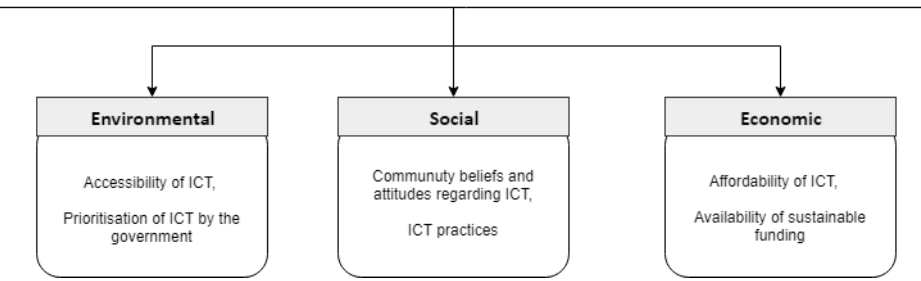
Figure 1. Environmental, social, and economic conditions that could guide the development of sustainable SLT service delivery approaches using ICT in SIDS.